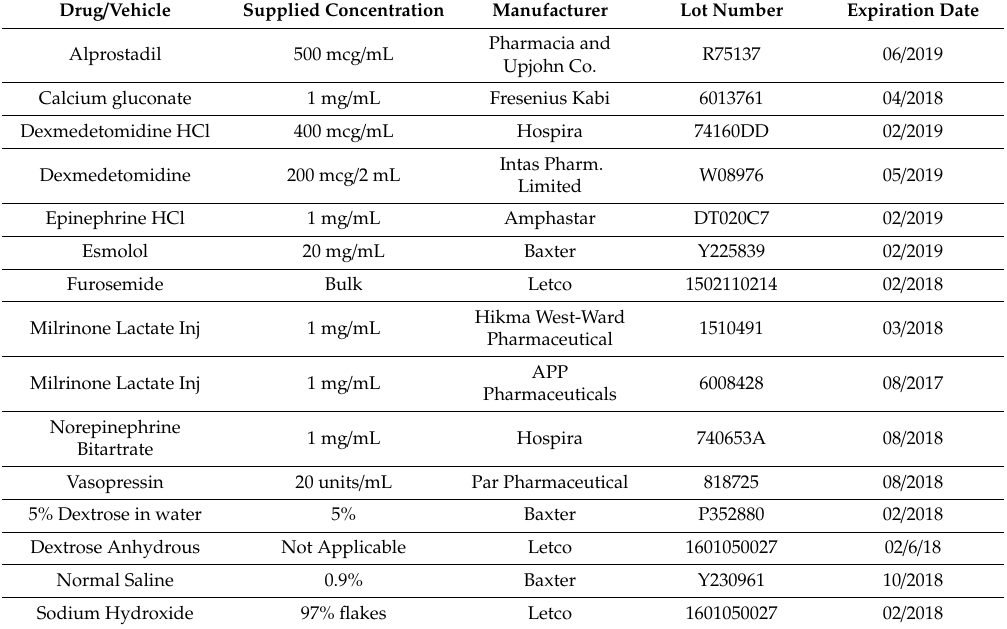
Table 1. Materials and vehicles.